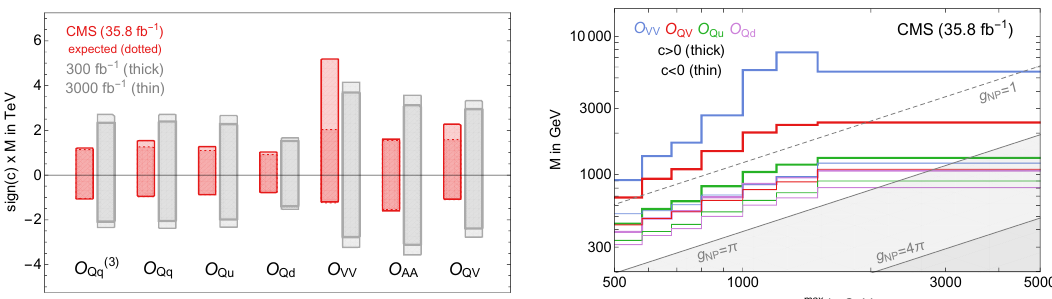
Figure 3 . Left : 95% CL limits on various dimension 6 operators, in terms of a reference mass p scale M (cid:17) m t = j c j (see eq. (3.1)), from CMS data (observed and expected bounds) and our high luminosity projection study of the t (cid:22) t invariant mass distribution. For each operator, the shaded region is excluded. Right : we show how the bounds degrade by only including in the (cid:12)t those events for which the reconstructed t (cid:22) t invariant mass is below a certain value m max lines correspond to positive (negative) operator coe(cid:14)cient which in turn corresponds to constructive (destructive) interference with the